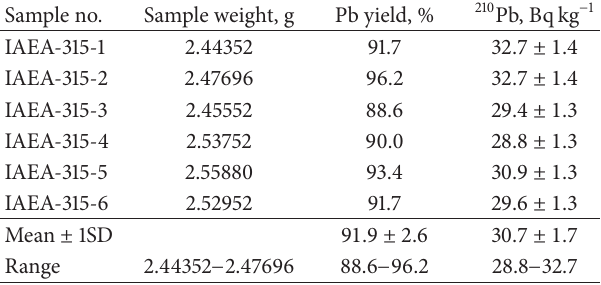
Table 5: Experimental values of 210 Pb activity concentrations (corrected to the date of 1st January 1993) in the IAEA-315 Marine Sediment ∗ . Sample